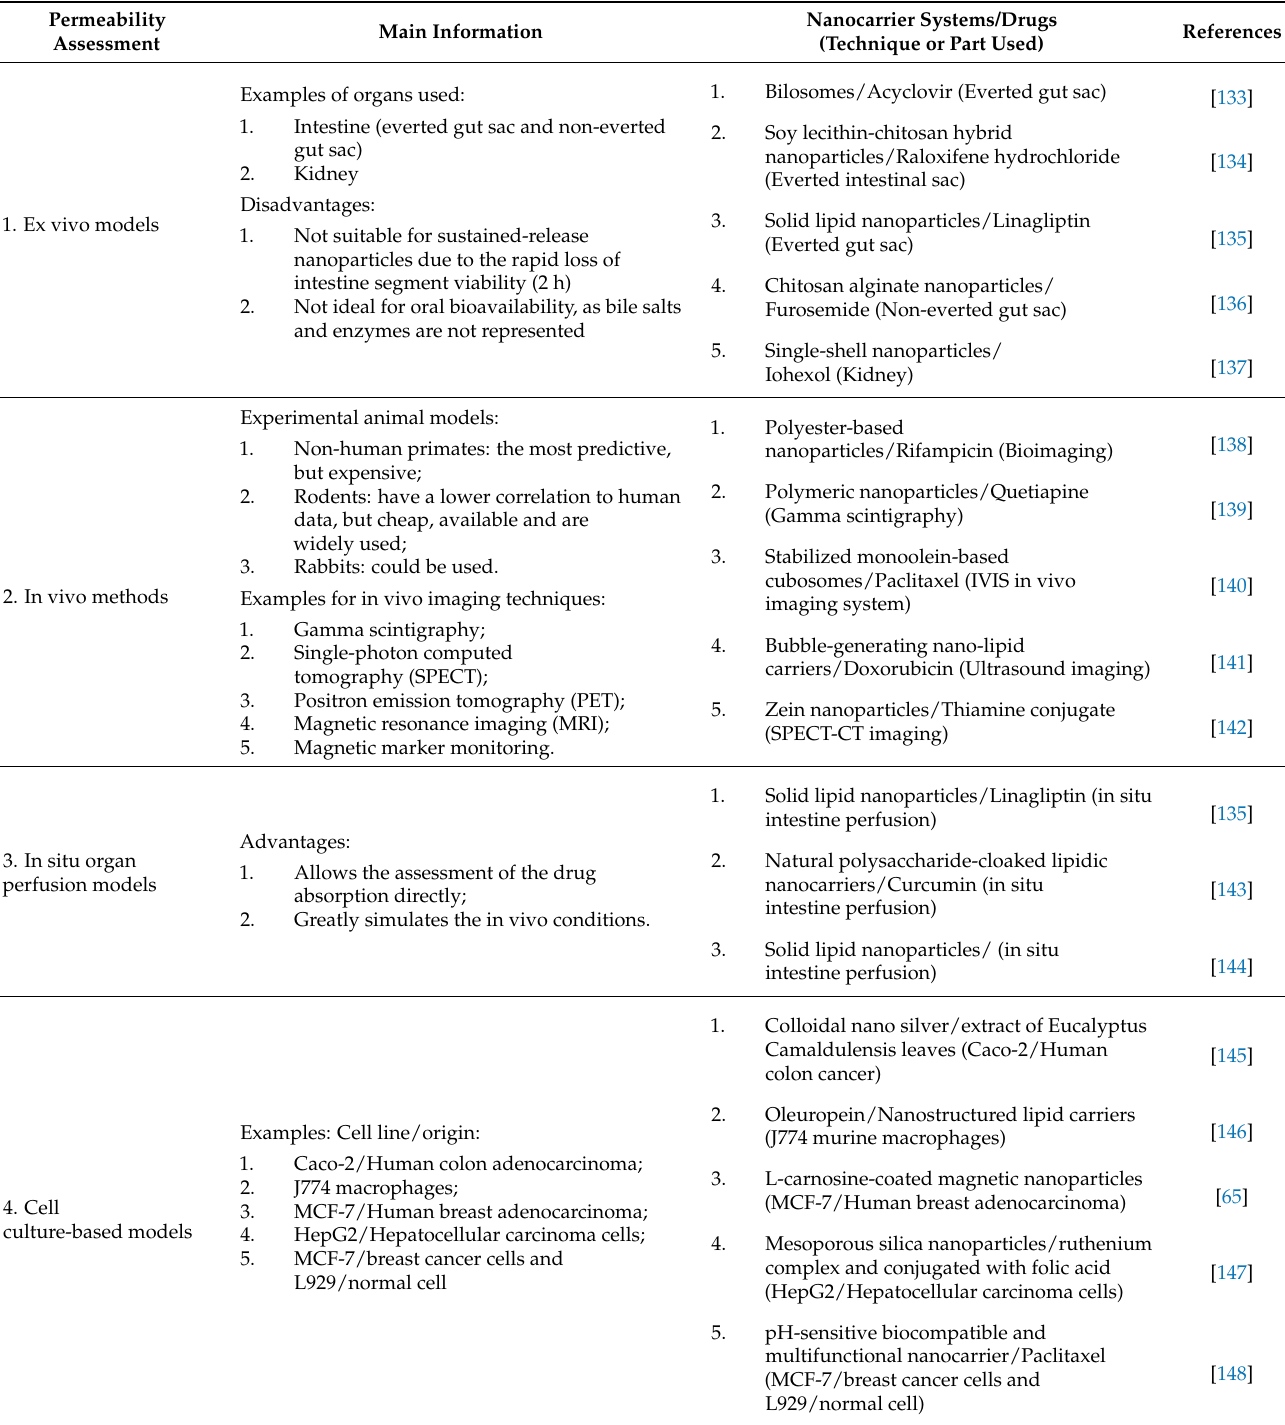
Table 2. Permeability assessment techniques of